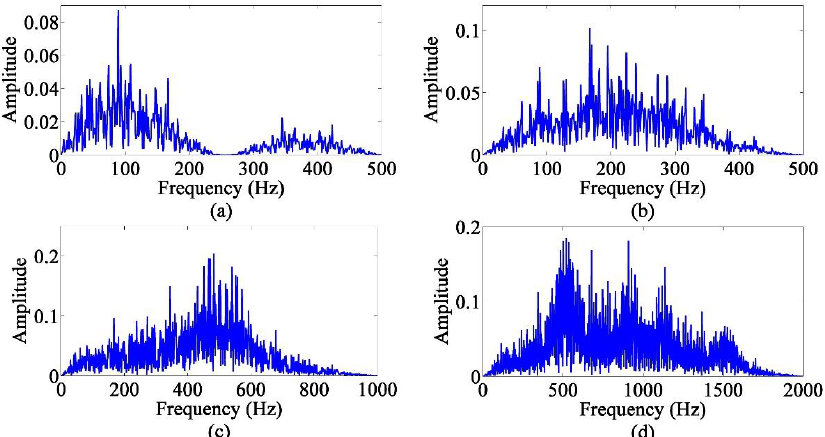
Figure 4. The amplitude spectra of each component after five-layer wavelet decomposition. ( a ) The fifth layer of the low-frequency component. ( b ) The fifth layer of the high-frequency component. ( c ) The fourth layer of the high-frequency component. ( d ) The third layer of the high-frequency component.